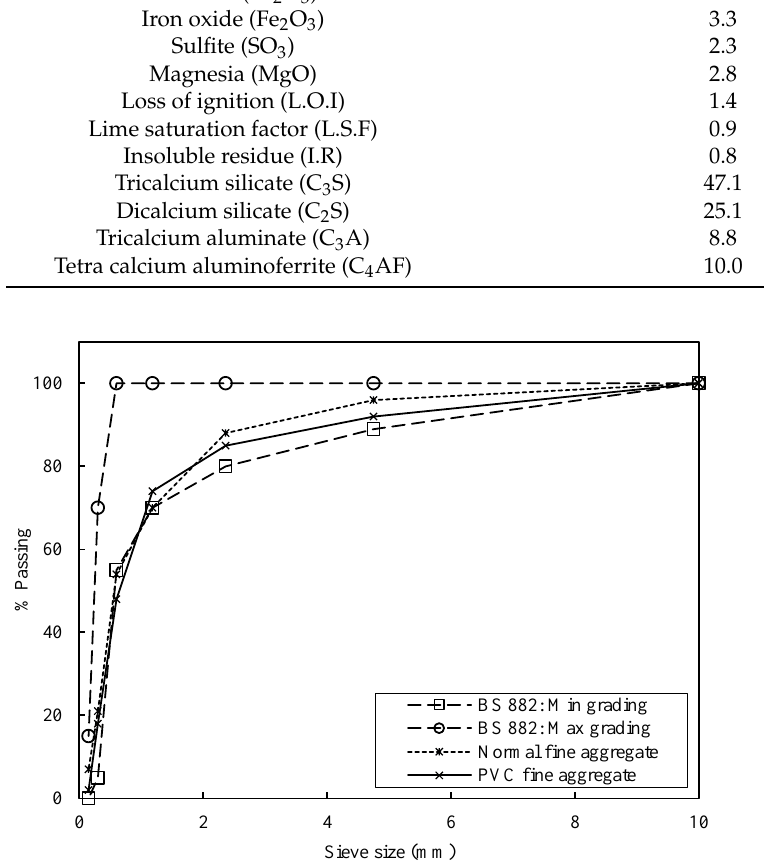
Figure 2. Fine Aggregate Sieve Analysis. Table 2. Material Properties used in concrete mixes.